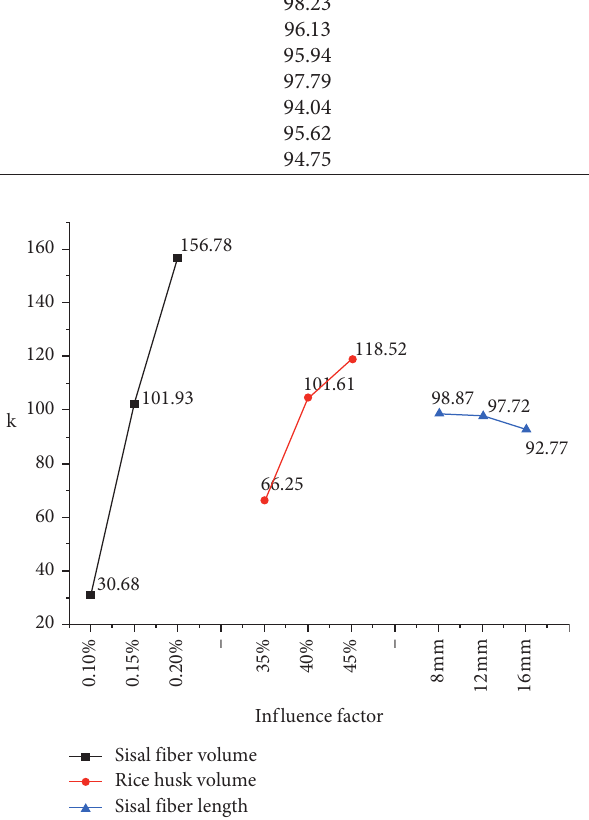
Figure 11: The k value diagram of factors affecting crack area.